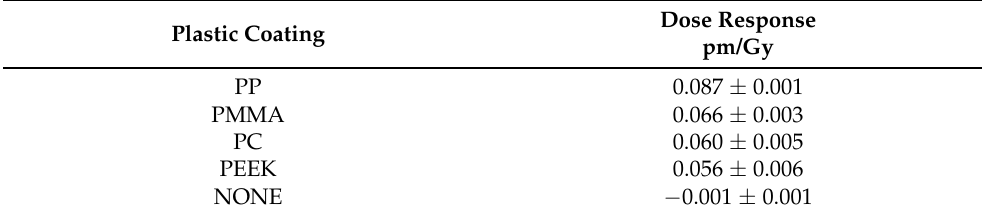
Figure 8. BWS in terms of dose for different coating (3 × 3 × 20 mm 3 ) and a non-coated fiber (NONE). The sensitivity of each plastic used for the fiber coating is listed in Table 4. Table 4. Dose response for different coating with a size of 3 × 3 × 20 mm 3 and a non-coated fiber